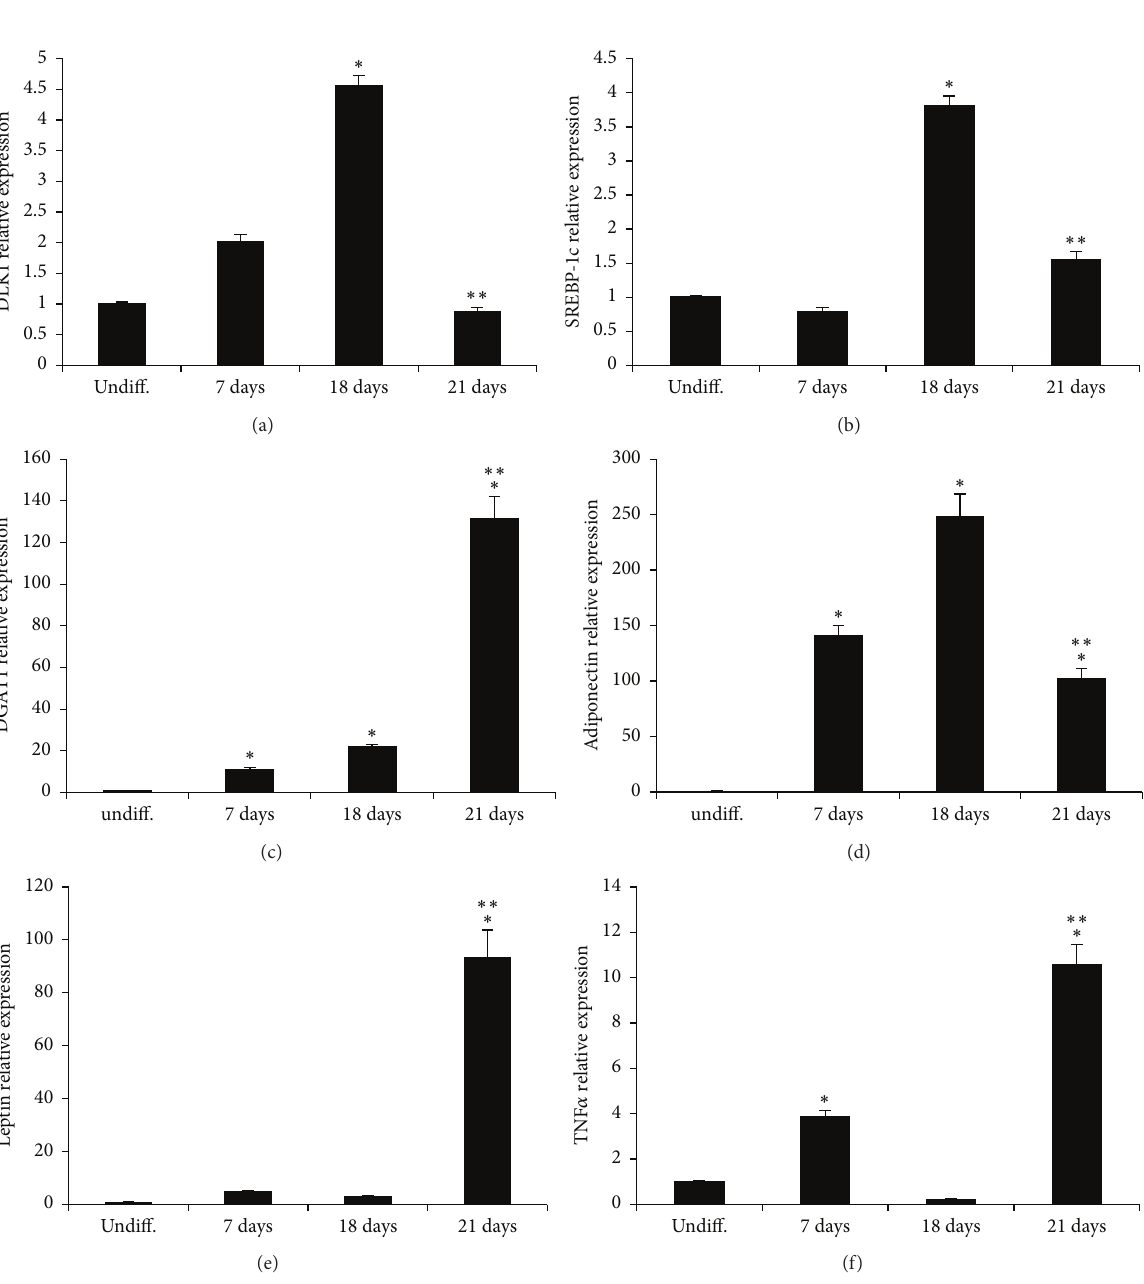
Figure 3: Expression of adipogenic markers and cytokines levels during adipogenesis. qRT-PCR revealed a marked increase of DLK1, SREBP- 1c, DGAT1, adiponectin, leptin, and TNF 𝛼 . Values represent the means ± SD of 4 experiments performed in triplicate. ∗ 𝑝 < 0.05 , significant result versus undifferentiated cells. ∗∗ 𝑝 < 0.05 significant result versus 18